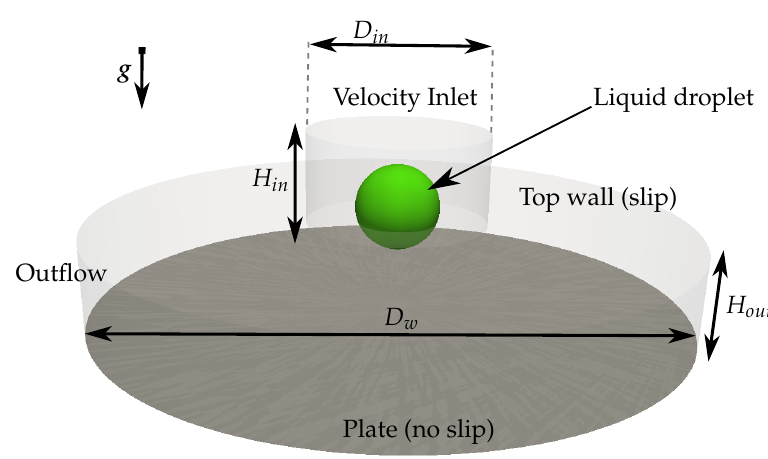
Figure 2. Sketch of the geometry for the validation